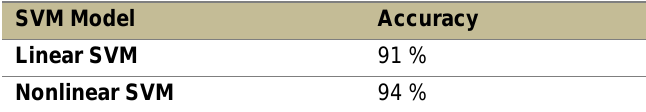
Table 5 – Аccuracy of linear and nonlinear SVM models Таблица 5 –Точность линейных и нелинейных